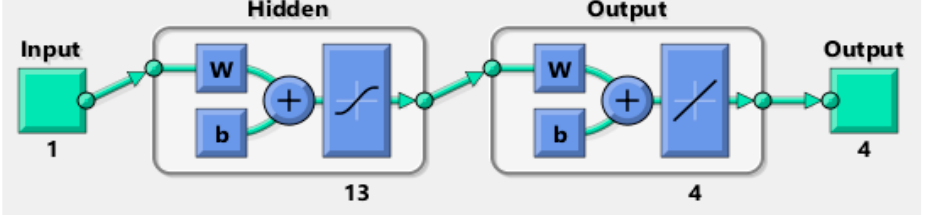
Figure 2. Input/hidden/output layers performances to solve the FO-MML model.